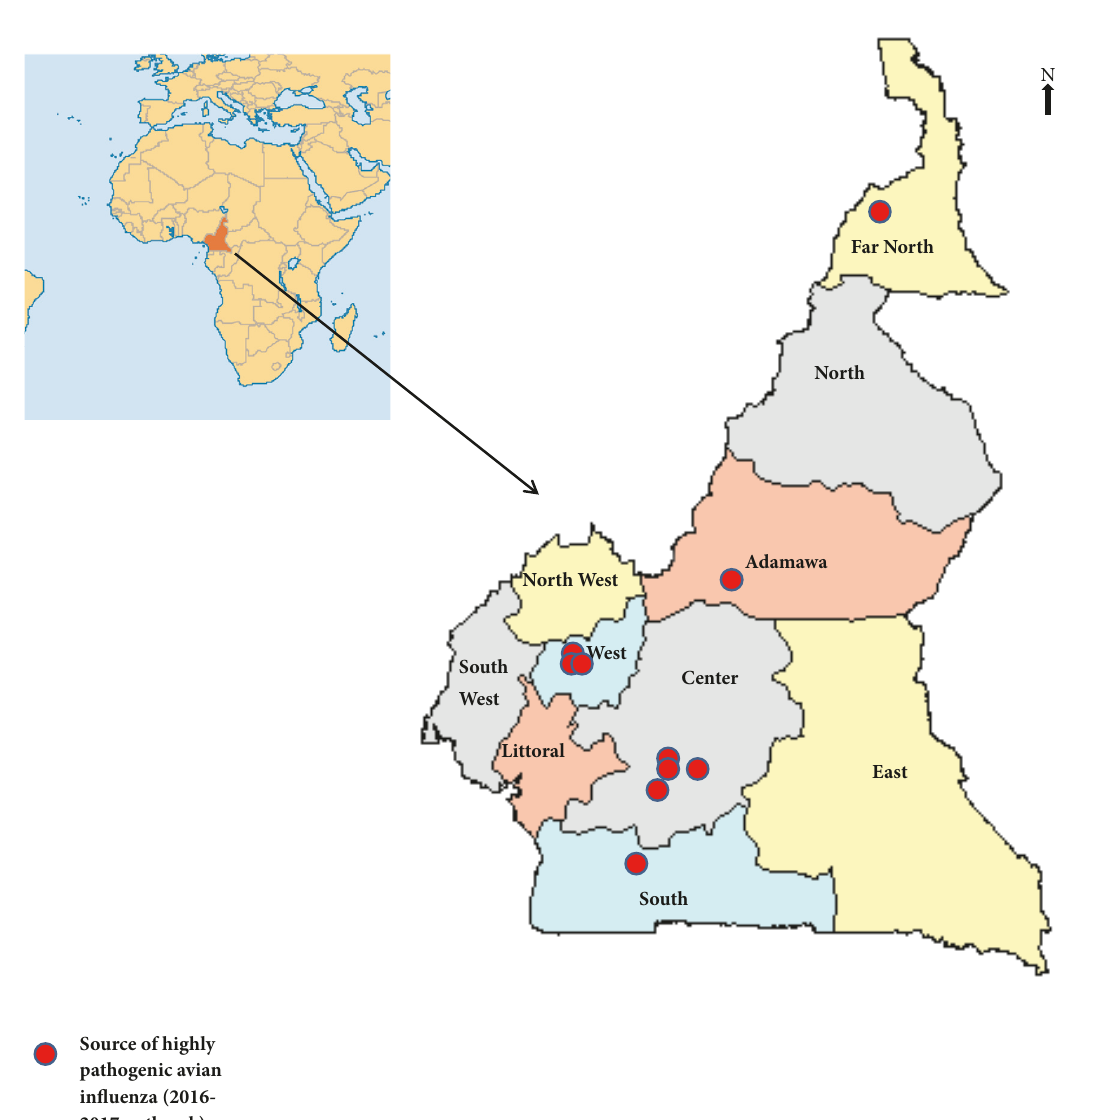
Figure 1: Map of Cameroon showing the sources of highly pathogenic avian influenza virus outbreak in Cameroon. (The H5N1 outbreak occurred in 2016 in the Center, South, West, and Adamawa regions while the H5N8 outbreak took place in the Far North Region in